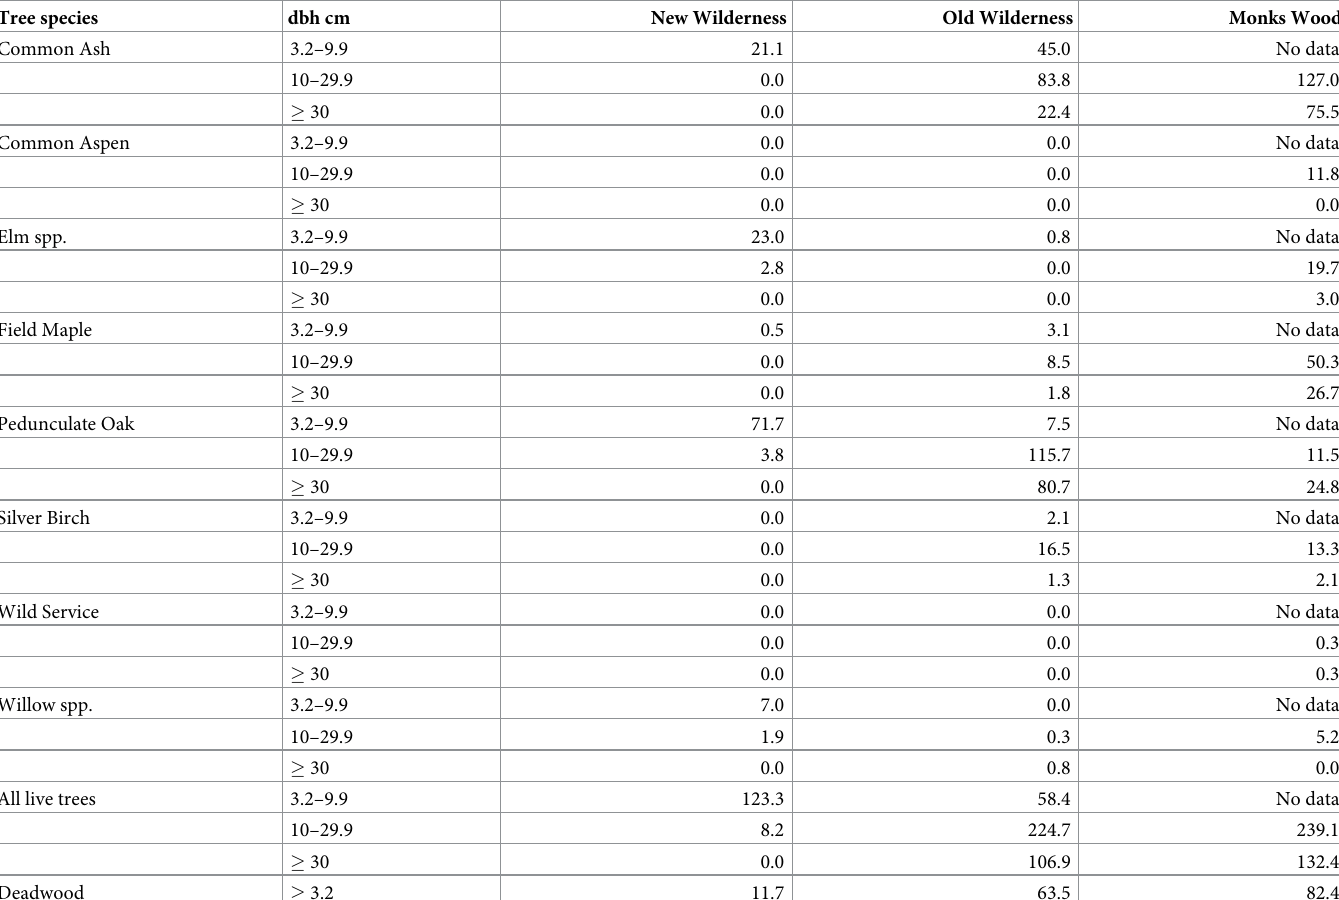
Table 1. Tree species data.